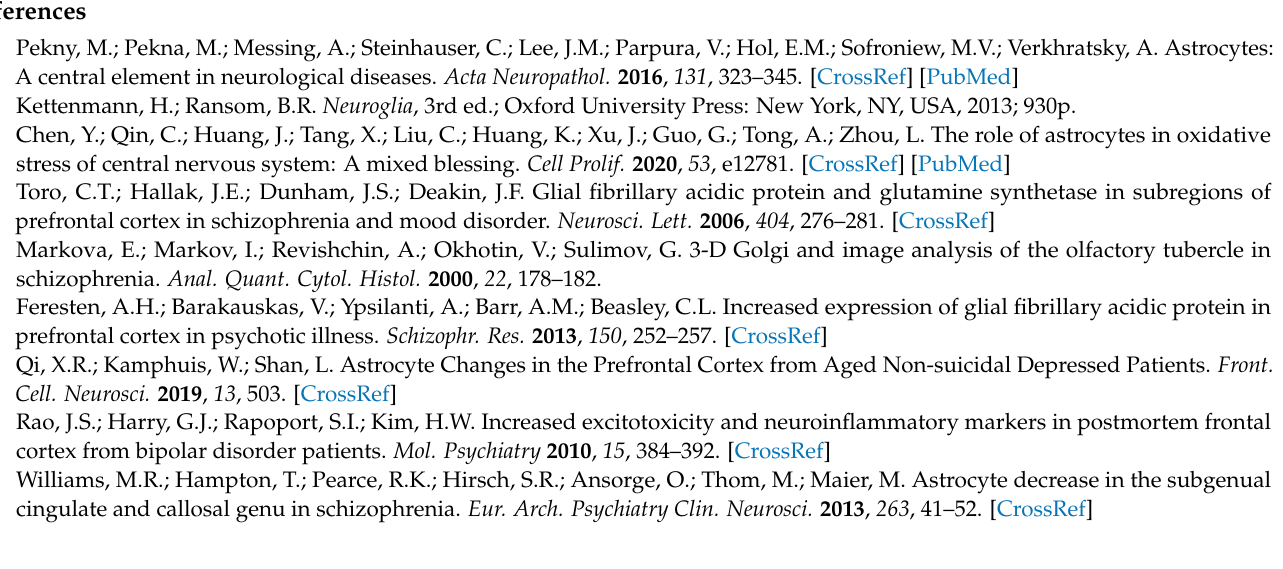
Table S2: Pathway enrichment in astrocyte and psychiatric disorder datasets; Table S3: Drug (DSigDB) gene sets; Table S4: Look-up" study of mouse_astrocyte “common” gene-set and psychotropic model datasets (Kaleidoscope); Table S5: GFAP, VIM, SOX9, EAAT2 in rodent psychotropic drug administration “look-up”